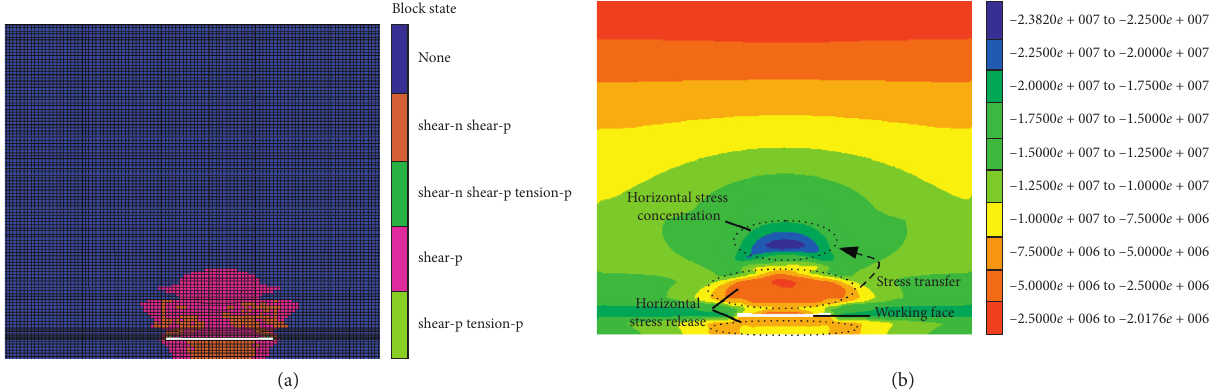
Figure 7: Distribution characteristics of the plastic zone and horizontal stress of the rock surrounding the stope. (a) Distribution of the plastic zone. (b) Distribution of the horizontal